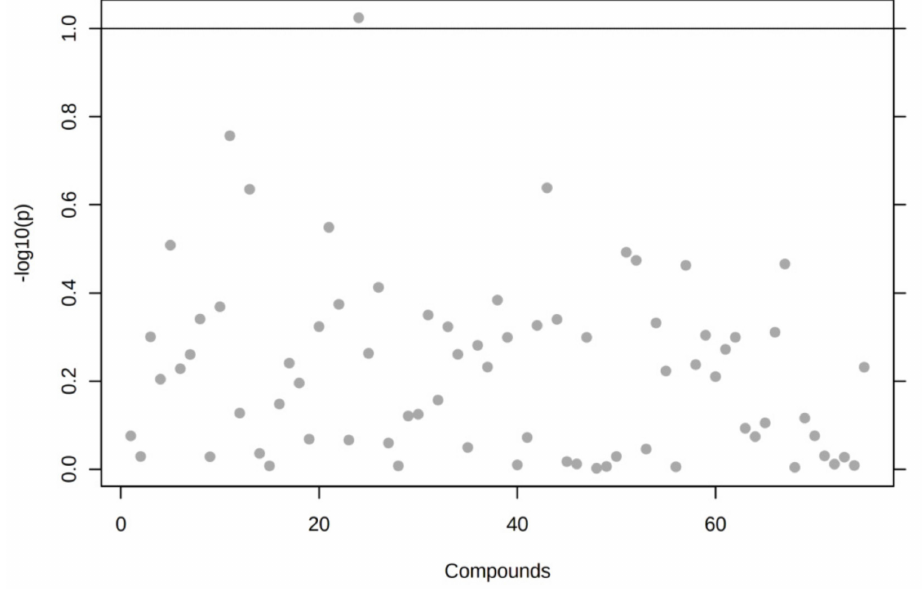
Figure A2. Graphical presentation of t-test analysis (FDR < 0.1) performed between T2DM and IFG study subjects (N = 38) by Metaboanalyst 4.0. No significantly changed miRNAs were